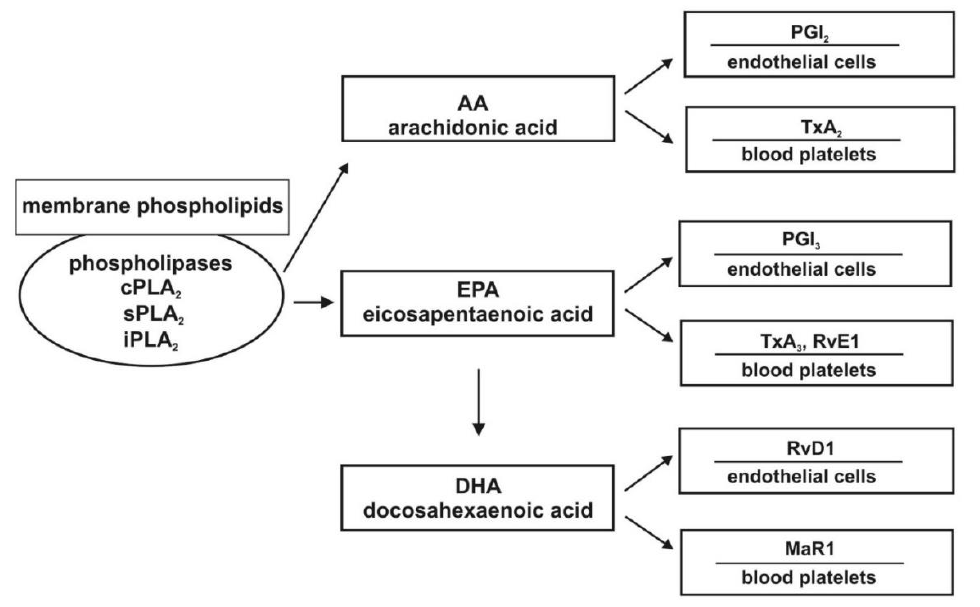
Figure 1. Association between metabolites of unsaturated fatty acids and platelets, as well as endothelial cells. Abbreviations: PLA 2 : Phospholipase A 2 ; MaR1: Maresin 1; PGI 2 : Prostacyclin; TXA 2 , TXA 3 : Thromboxanes; RvE1: Resolvin E1; RvD1: Resolvin D1; AA: Arachidonic acid; DHA: Docosahexaenoic acid; EPA: Eicosapentaenoic acid.